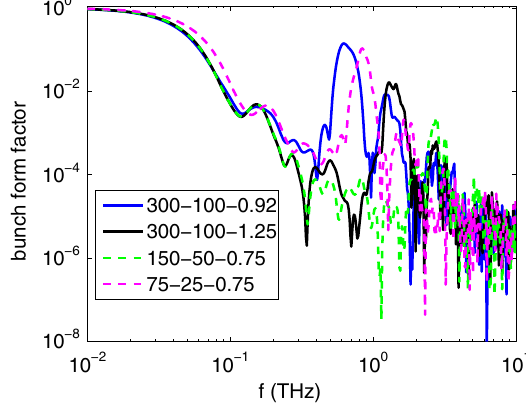
FIG. 12. Bunch form factor associated to train of micro- bunches obtained downstream of the EEX beam line. The four traces correspond to four configurations indicated in the legend as ‘‘ (cid:2)w (cid:1) w (cid:1) F ’’ where (cid:2)w and w are, respectively, the slit edge-to-edge separation and width in micrometers, and F is a scaling factor for the quadrupoles Q1, Q2, Q3, and Q4 [when F ¼ 1 the quadrupoles are tuned to match the horizontal C-S Þ ¼ ð 2 ; 12 m Þ upstream of the ; (cid:1) parameter to ð (cid:3) x; 0 x; 0